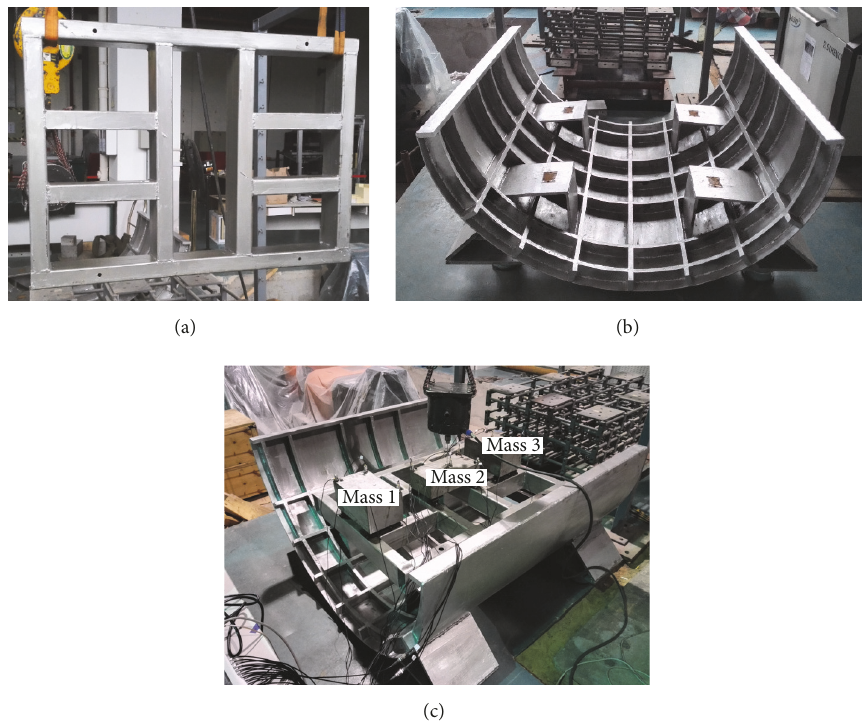
Figure 6: (a) Test model of the raft; (b) test model of the hull with base; (c) test model of the floating raft system without attached pipes.